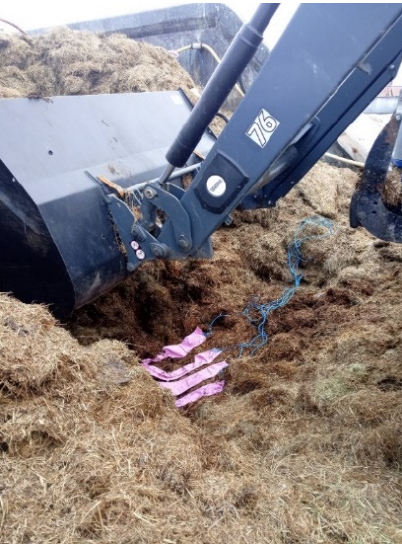
Figure 2. The farm-scale patch-reactor samples were set inside polyester bags that were set into the bottom, middle and on top of the biomasses. (Photo: Marjaana Hassani).